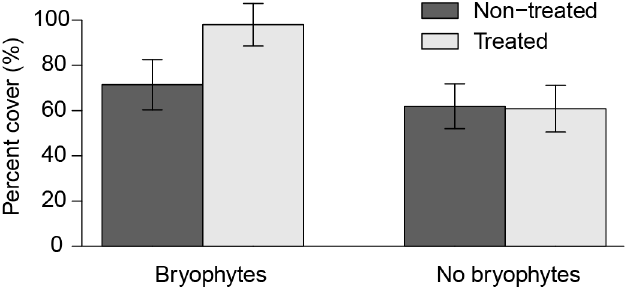
Figure 6. Effect of bryophytes (forest floor mosses only) on total understory plant cover between untreated and treated